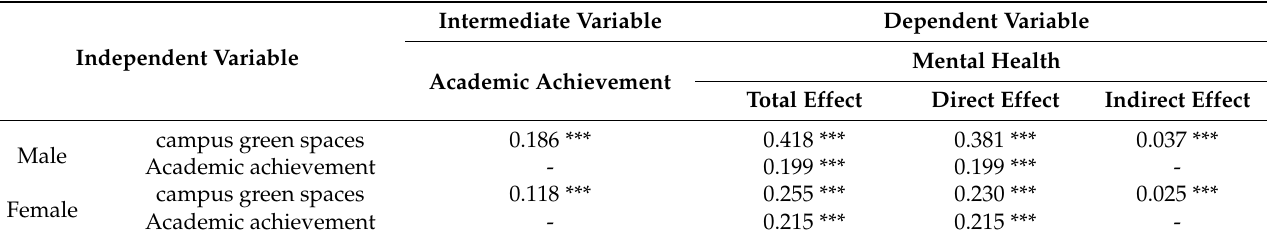
Table 5. Comparison of the model paths in different gender groups.